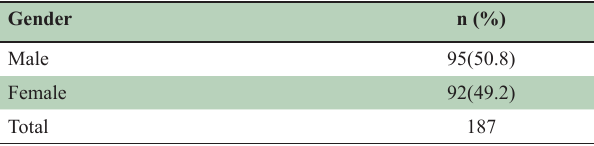
Out of 82 smoker patients, 27(32.9%) patients had positive Gene Xpert and out of 105 non-smoker patients, 22(21%) had positive Gene Xpert with p-value=0.065 Table-VI. Table-I: Frequency distribution of gender.